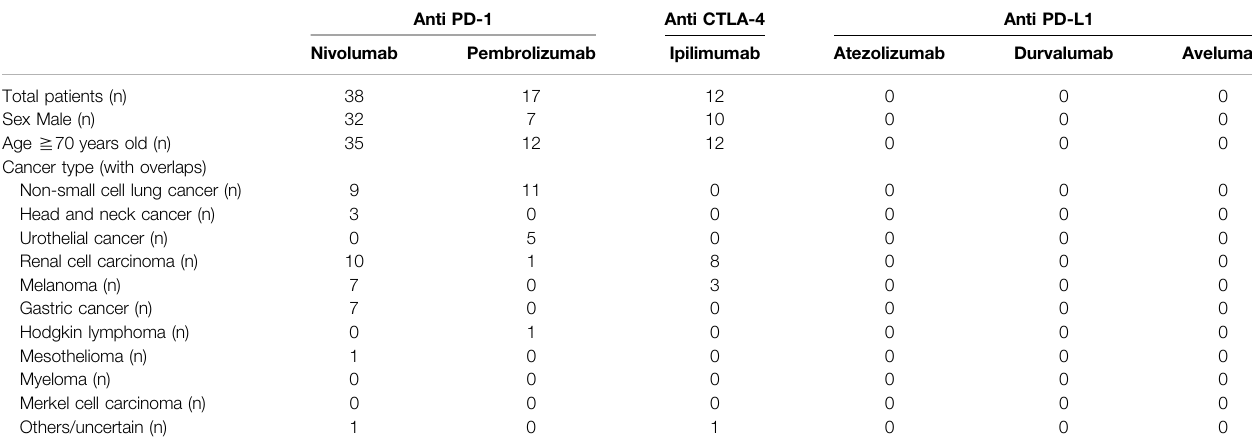
TABLE 4 | Characteristics of patient with polymyalgia rheumatic.